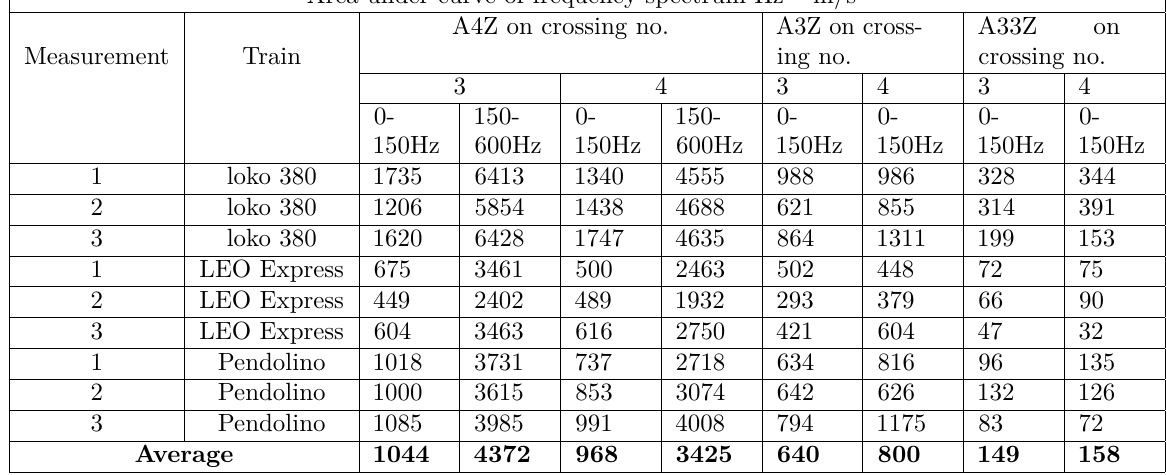
Table 2. Area under frequency curve divided in to two frequency